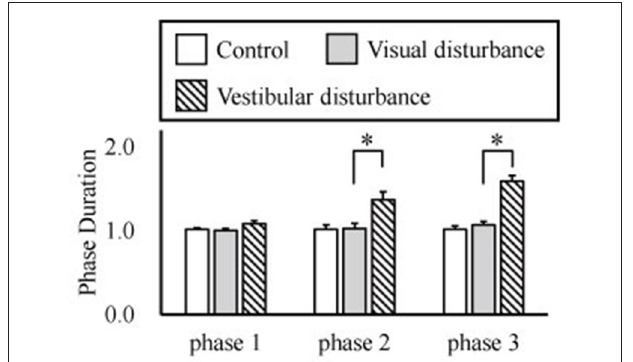
FIGURE 6 | Average and standard deviation of the durations of the phases in sit-to-stand motion. The duration of phase 4 was determined by the duration of phases 1–3, and thus, it is not shown above. According to the results of the statistical test, the durations of phase 2 and 3 were significantly longer under the vestibular-disturbance condition than under the visual-disturbance condition.